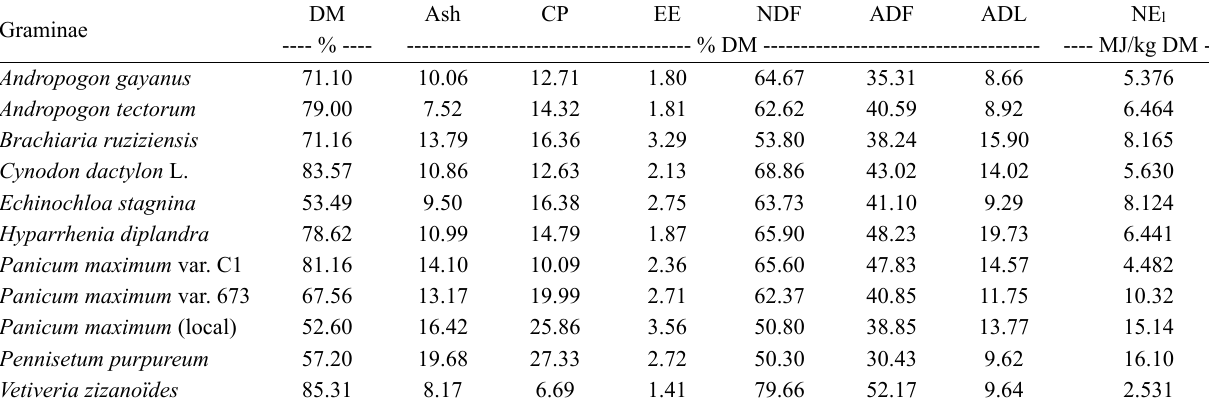
Table 1. Chemical composition and nutritive value of grass forages DM Ash CP EE NDF ADF ADL NE l Graminae ---- % ---- -------------------------------------- % DM ------------------------------------- ---- MJ/kg DM ---- Andropogon gayanus 71.10 Andropogon tectorum 79.00 Brachiaria ruziziensis 71.16 Cynodon dactylon L. 83.57 Echinochloa stagnina Hyparrhenia